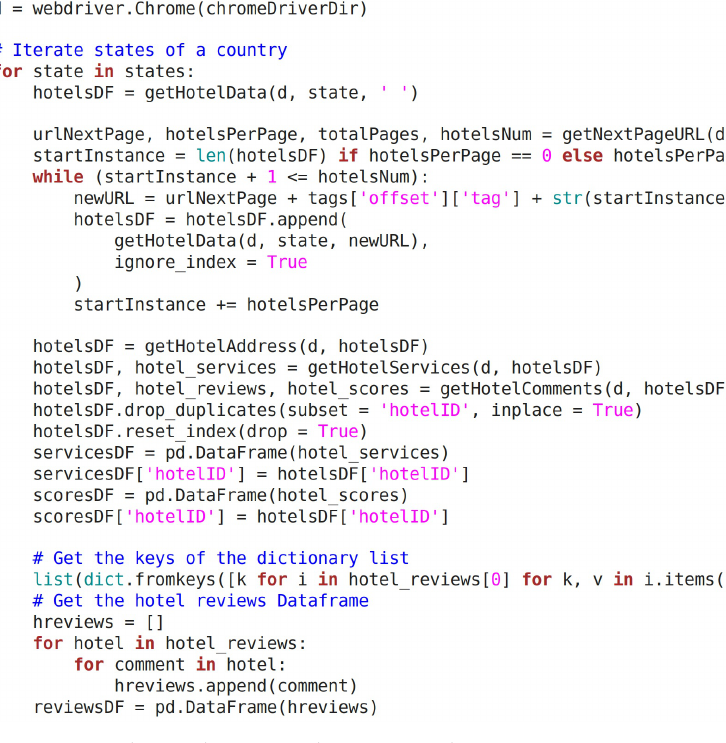
Figure 11. Python code snippet about OTA web